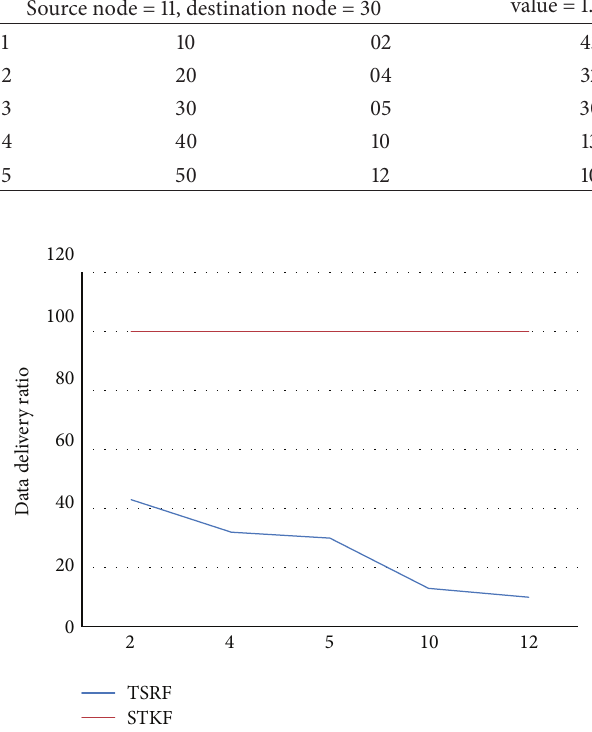
Figure 8: A graph between data delivery ratio and number of malicious nodes in the route (TSRF with trust value = 0.0027 & STKF with trust value =